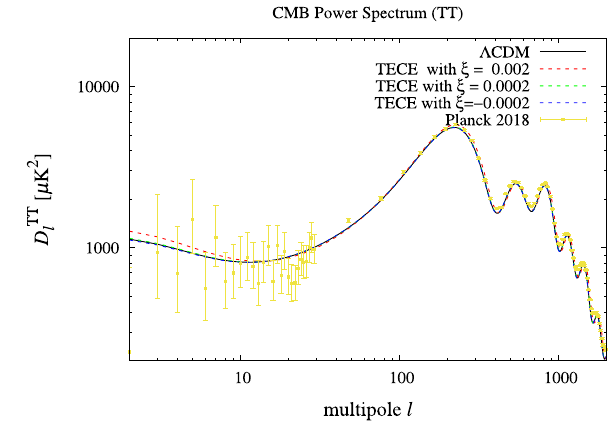
Fig. 5 The change (cid:9) D TE (cid:10) of the TT mode of CMB power spectra between PLCE and (cid:2) CDM, where the legend is the same as Fig. 4